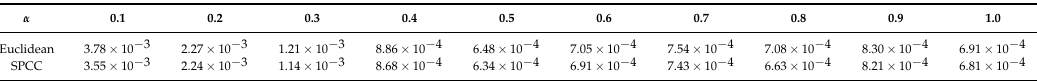
Table 1. I SD index scores of DOE (simulated) data set.